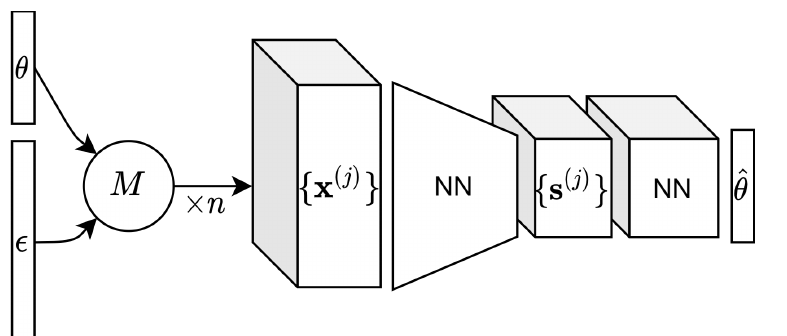
Figure 2: Basic INCA architecture: The encoder is trained on sets of model realizations { x ( j ) } , for fixed parameter values, and produces the corresponding sets of summary statistics { s ( j ) = s ( x ( j ) ) } . The decoder is a NN acting on auxiliary summary statis- ( j ) } , for β = p + 1,..., q to find a weighting function w to reconstruct model tics { s β parameters, based on eq.